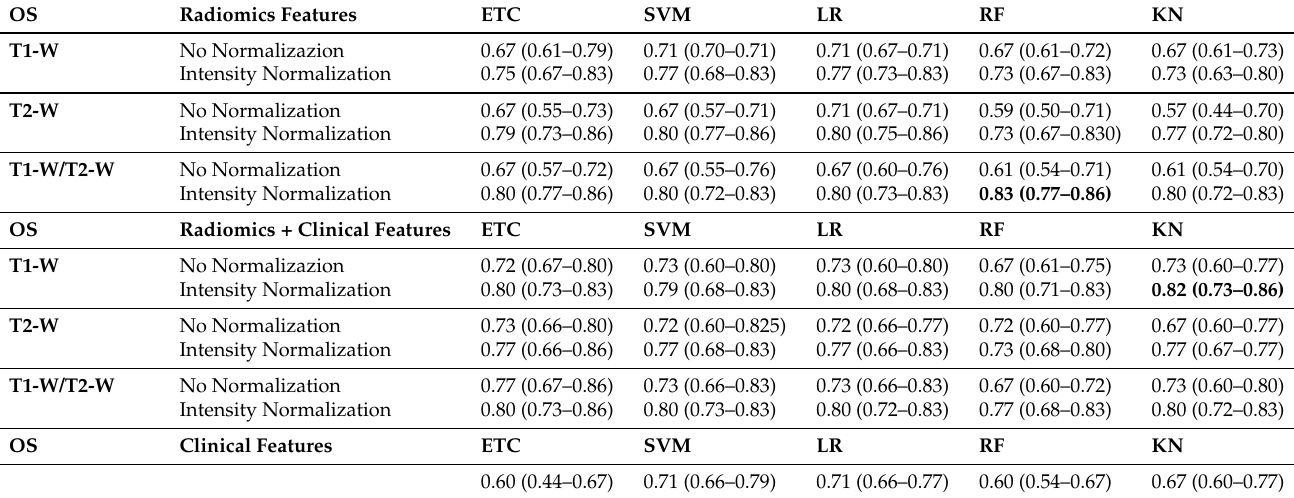
Table 2. median ± quartiles of the F1-Score (T1-W and T2-W and combination T1-W and T2-W), obtained using all 5 test folds with 10 repeated of the cross-validation and 5 machine learning models. The difference between the quartiles provided information on the distribution of results. Each result was compared with features extracted from non-normalized images and normalized images using only radiomics features, radiomics plus clinical features and only clinical